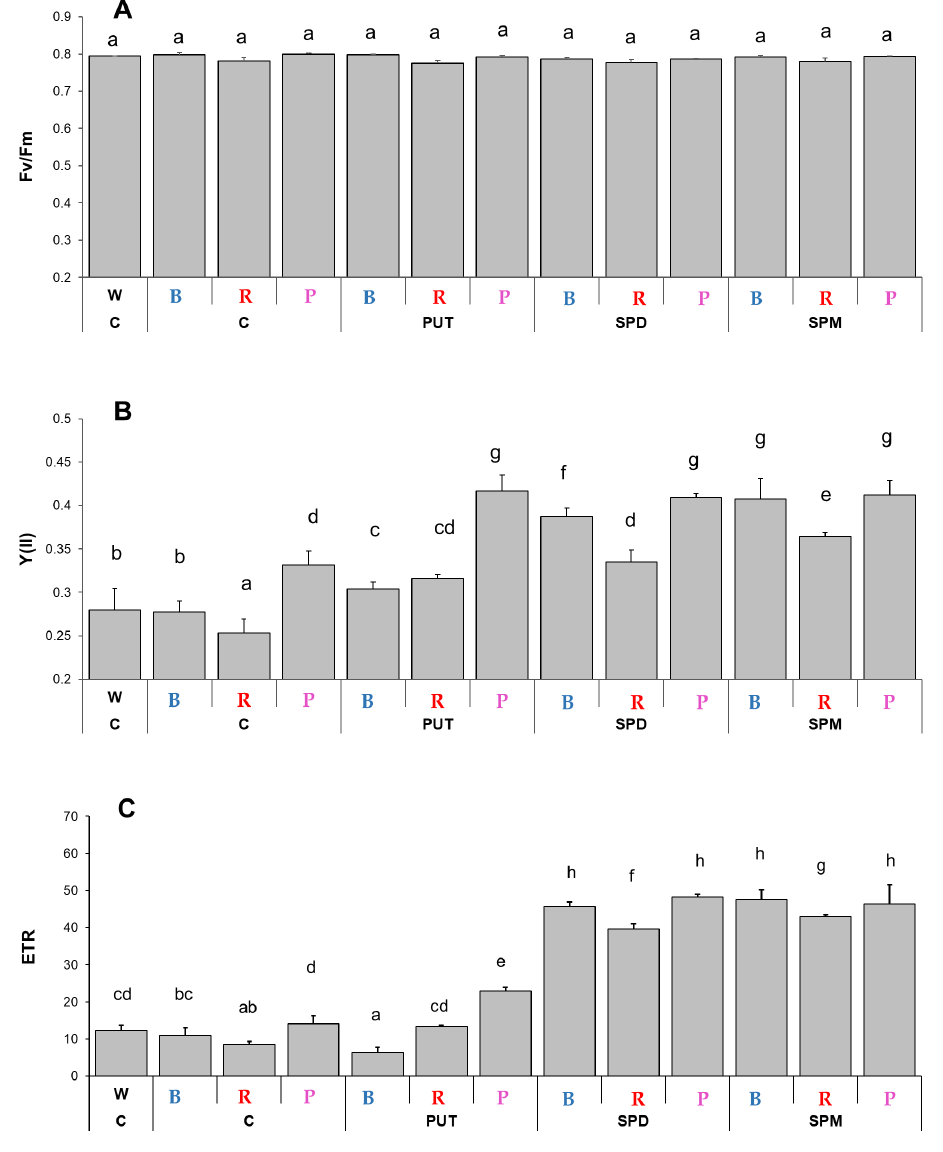
Figure 1. Cholorphyll- a fluorescence induction parameters. ( A ): Maximum quantum yield of PSII (F v /F m ), ( B ): actual quantum yield of PS II [Y(II)], and ( C ): the electron transport rate (ETR) deter- mined at the steady state level of photosynthesis on the third fully expanded leaves of plants grown under different light regimes [(white light (W), blue light (B), red + far-red: R and the combination of blue and red + far-red, called pink (P)] treated with or without polyamines (control: C, putrescine: PUT, spermidine: SPD and spermine: SPM). Values are means ± SD ( n = 6). Different letters indicate statistically significant differences at p < 0.05 level, using Duncan’s post hoc test.